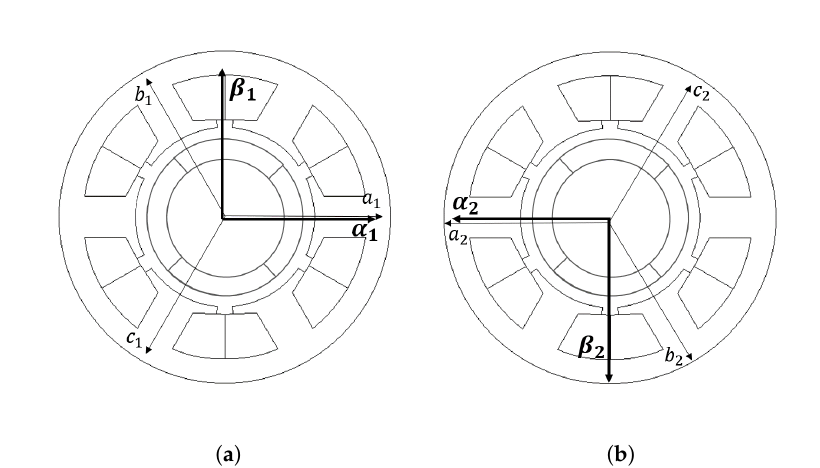
Figure 2. abc to αβ transformations: ( a ) a 1 , b 1 , c 1 , and α 1 , β 1 ; ( b ) a 2 , b 2 , c 2 , and α 2 , β 2